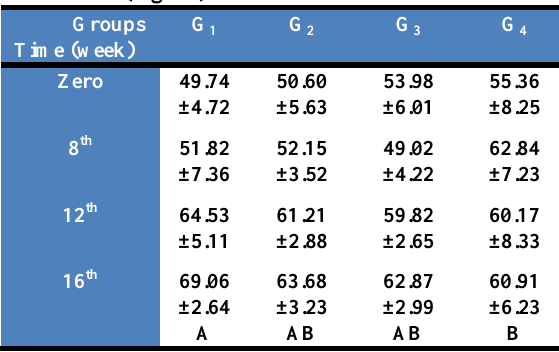
Table, 2: The effect of potassium nitrate and vitamin C as feed additive to the feed of rabbits on the serum cholesterol (mg